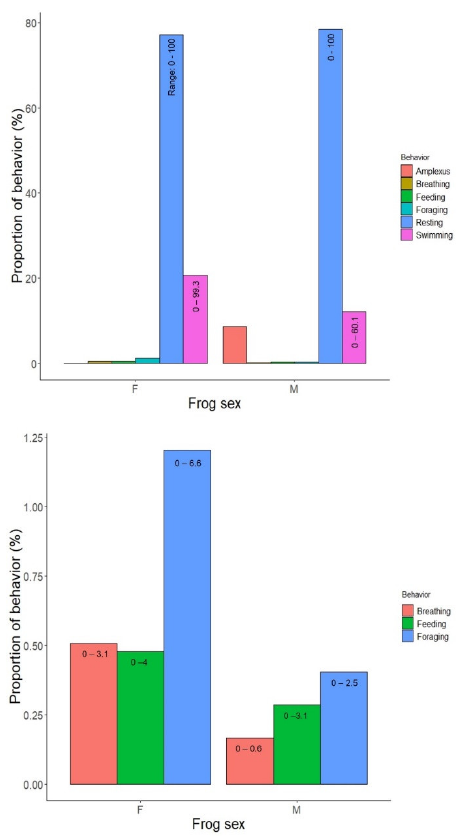
Figure 1. Diurnal activity budget of male and female X. longipes ; data are expressed as percentages of total behavior duration pre-disturbance across AM, noon, and PM observations. Sloughing is not shown as it was not recorded during the observation periods. The lower pane shows the three behaviors that are not visible in the top pane at a different scale for clarity. The range of percentages has been displayed for each behavior by subtracting the smallest percentage of total behavior pre- disturbance from the greatest percentage of total behavior